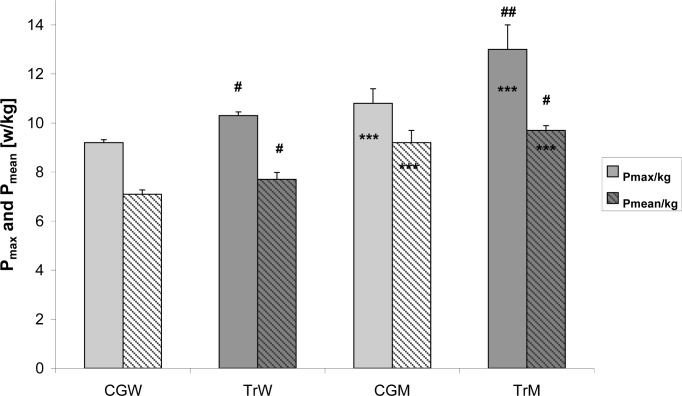
Maximal anaerobic power (Pmax) and mean anaerobic power (Pmean) of trained women (TrW) and men (TrM) compared to control subgroups: female (CGW) and male (CGM). Significant differences between women and men (***p<0.001) and between trained and untrained subjects (# p<0.05; ## p<0.01)